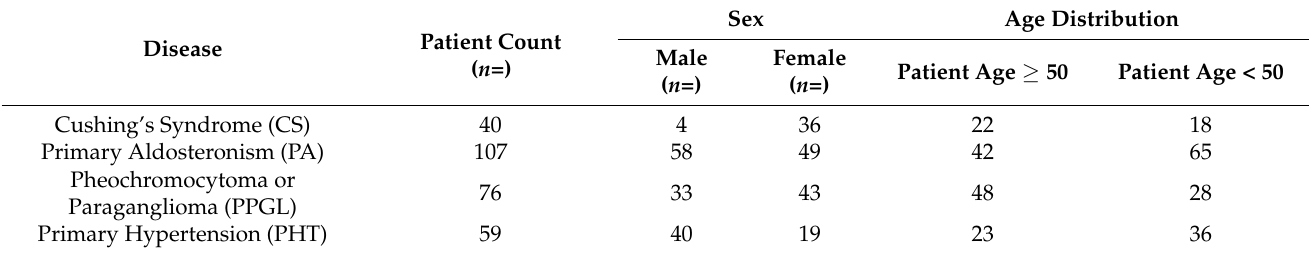
Table 1. Patient data for all disease types namely Cushing’s syndrome (CS), primary aldosteronism (PA), pheochromocytoma or paraganglioma (PPGL), and primary hypertension (PHT). There was a significant difference in the distribution of patients according to sex ( p < 0.001) and age ( p = 0.006) between the disease groups. The difference was significant also when considering CS, PA, and PPGL in the common EHT group for sex ( p = 0.009), but not for age ( p = 0.088). For distribution